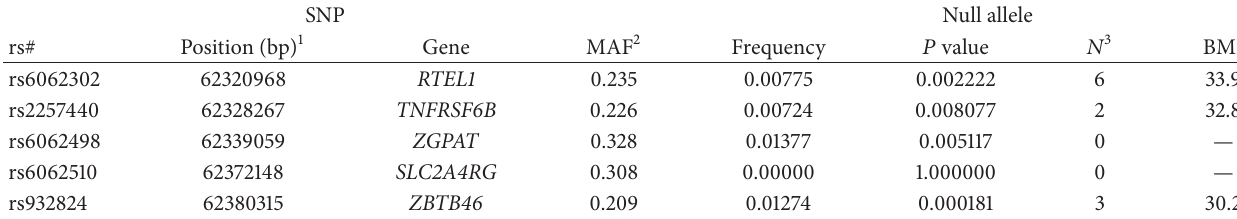
Table 5: Chromosome 20 SNPs tested for evidence of null